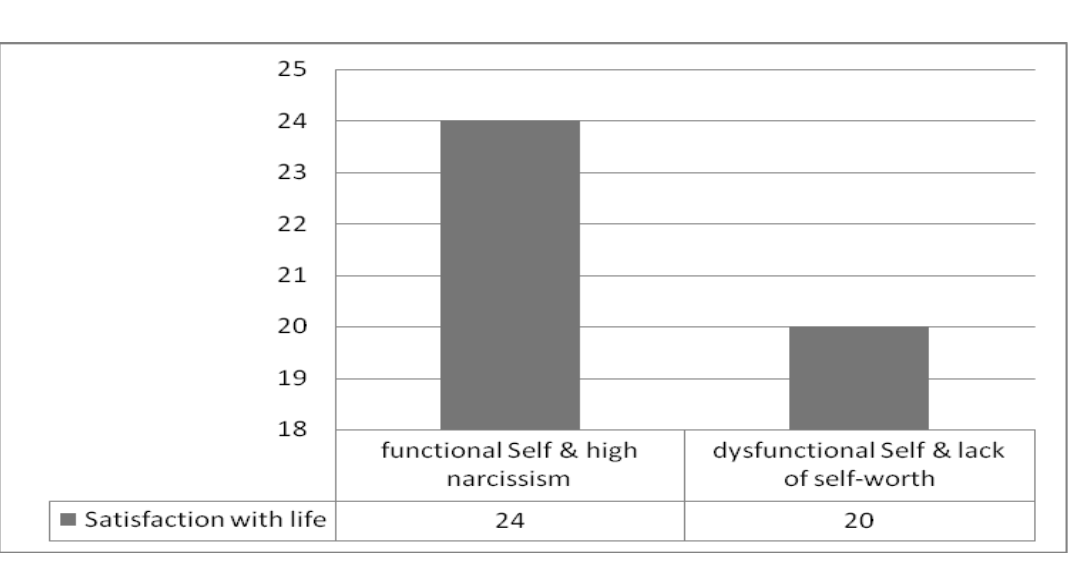
Graphic depiction of satisfaction with life of distinct narcissistic self-regulation